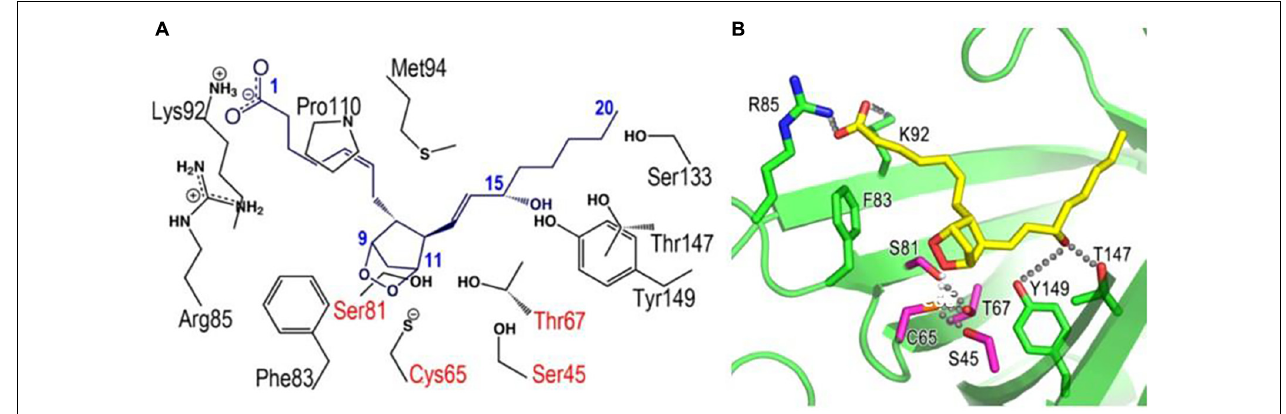
FIGURE 4 | Docking models of L-PGDS complexes with PGH 2 based on X-ray crystallography (Kumasaka et al., 2009). Amino acid residues important for interaction with PGH 2 are shown in panel (A) . R85, K92, F83, S82, C65, S45, T67, Y149, and T147 are shown in stick-model form in panel (B) . Hydrogen bonding network around Cys65 and 15-hydroxy group of PGH 2 are also indicated in panel (B)